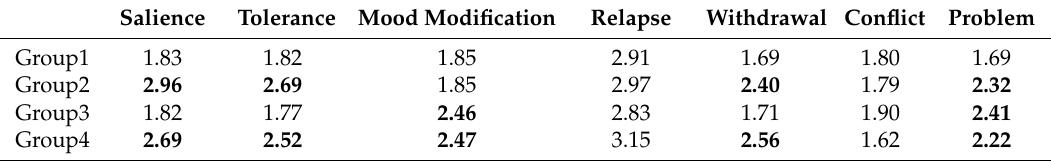
Table 4. Mean scores for addiction in esports among groups and scale